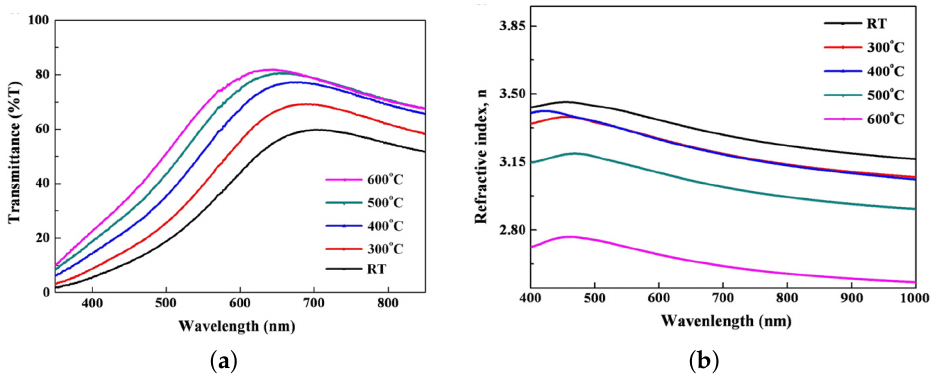
Figure 7. Evolution of ( a ) the transmittance and ( b ) the refractive index as a function of the tempera- ture of the substrate, after Seo team [104]. Reprinted with permission from